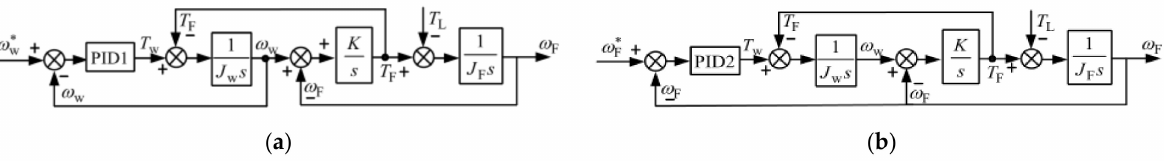
Figure 9. The transfer function structure diagram of suppressing elastic vibration by PID controller. ( a ) Wind turbine speed feedback control; ( b ) Generator speed feedback